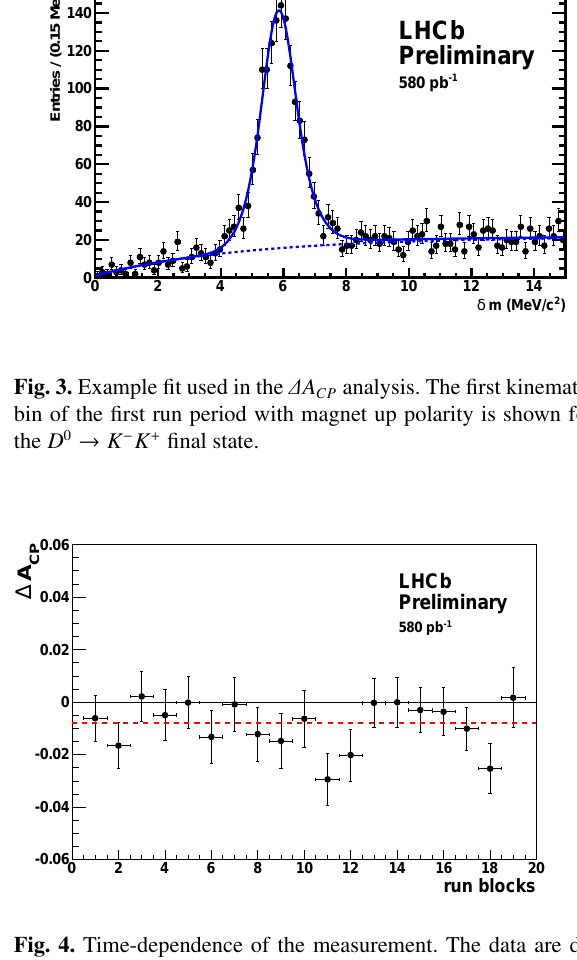
Fig. 4. Time-dependence of the measurement. The data are di- vided into 19 disjoint, contiguous, time-ordered blocks and the value of ∆ A CP measured in each block. The red dashed line shows the result for the combined sample.